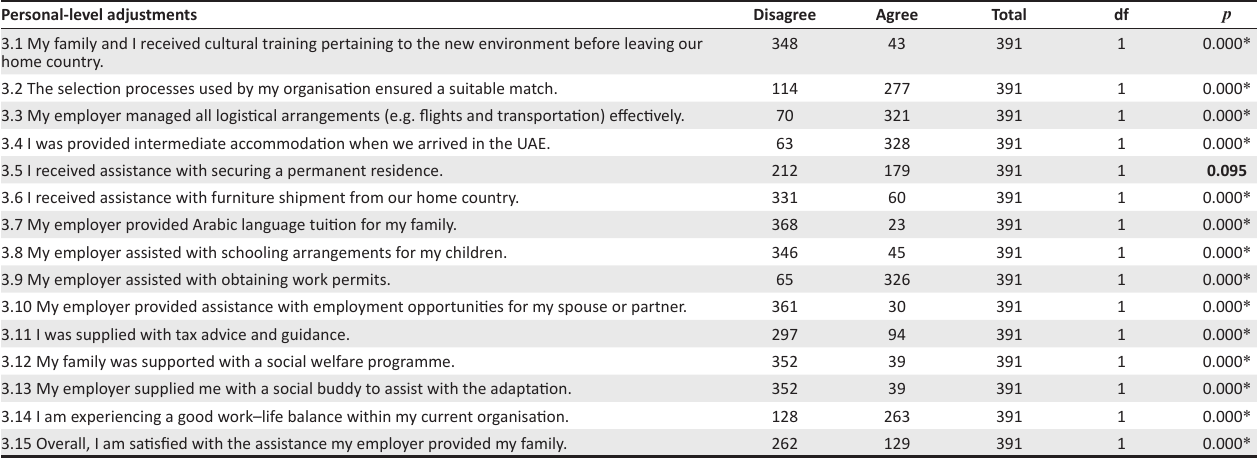
TABLE 3: Pearson chi-square test results for personal-level adjustment.